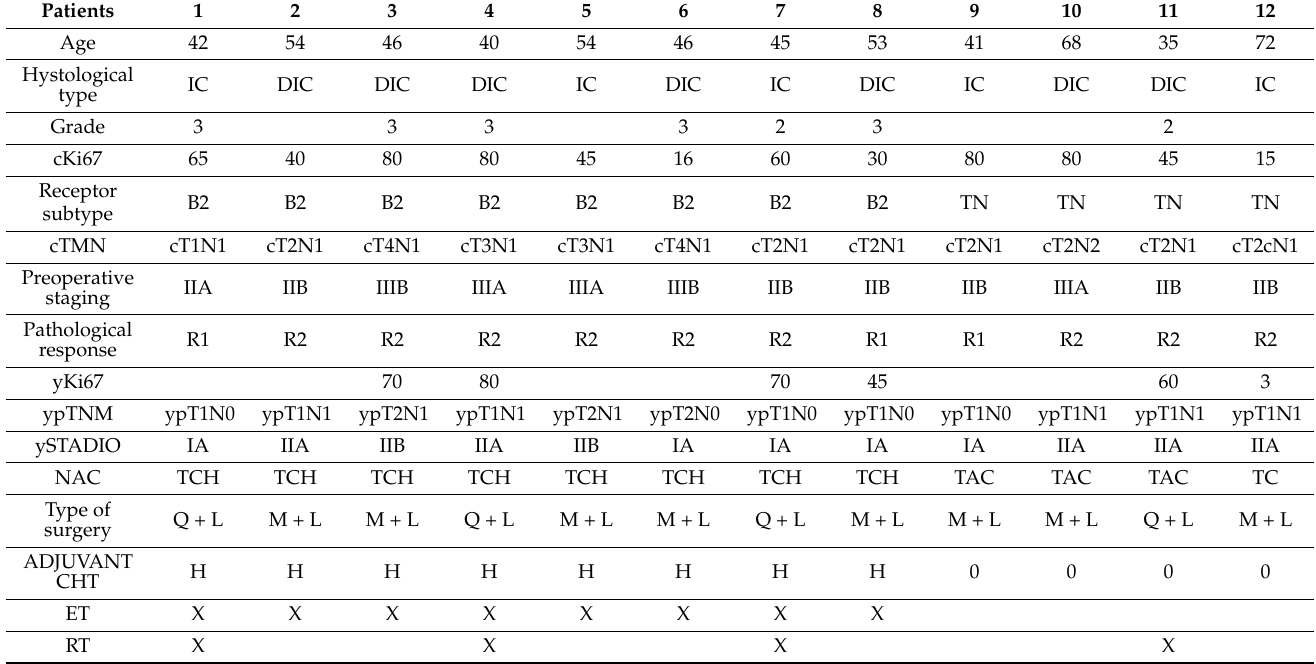
Table 2. Clinicopathological characteristics of breast cancer selected patients (N 1–12).